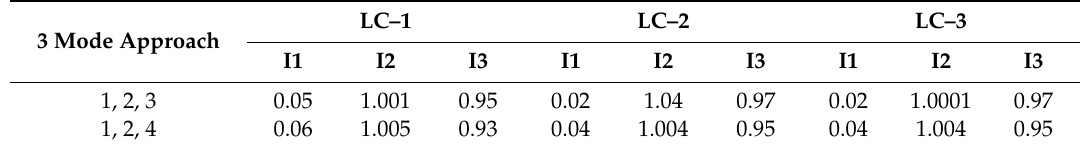
Table 11. Dimensionless coe ffi cients I1, I2 and I3 for LC–1, LC–2 and LC–3.